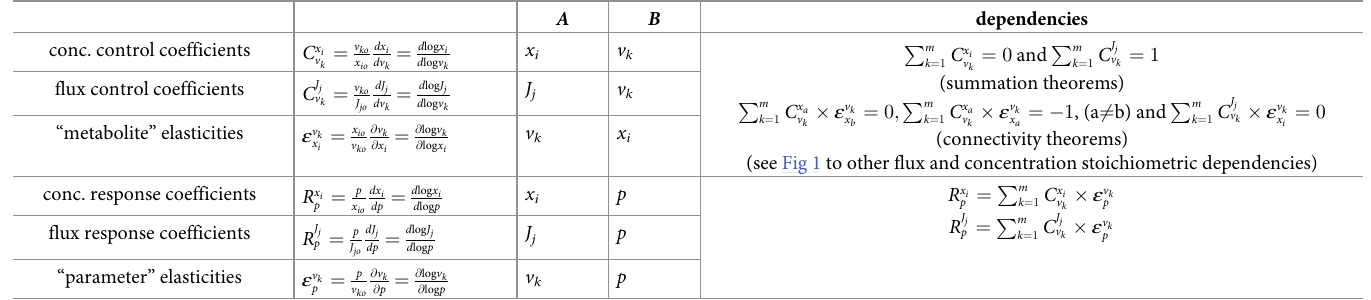
Table 1. Sensitivity